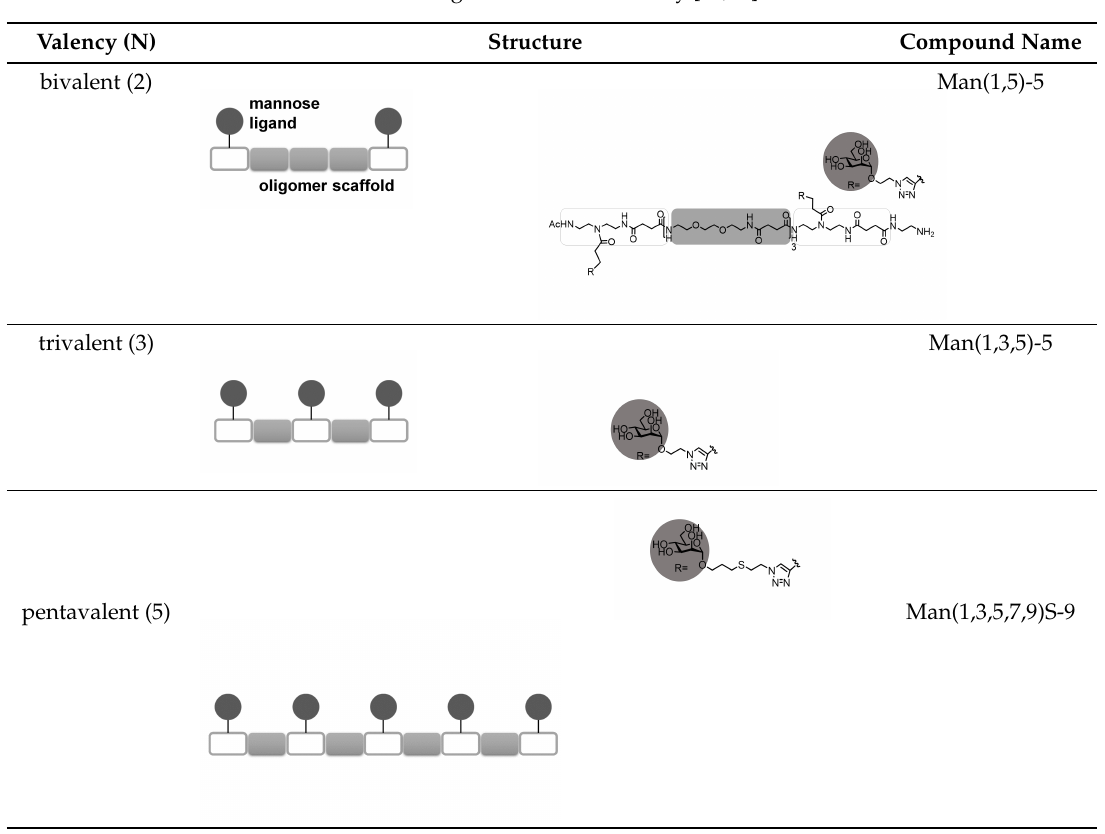
Table 1. Ligands used in the study